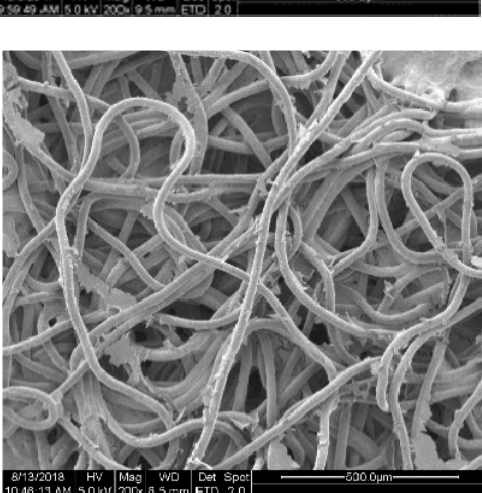
Figure 2. SEM images of spun-bonded biodegradable nonwoven after activation, 200×. The nonwoven was activated by the padding method, which did not change the morphology of the fibers. The applied substances covered the fibers without damaging their structure [55]. The biodegradable spun-bonded nonwovens with active layers are shown in Figure 2.